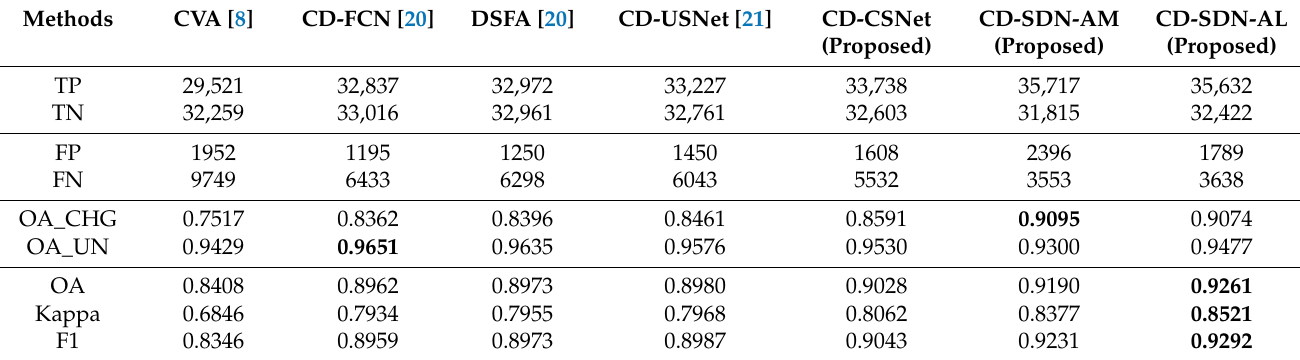
Table 3. The comparison of quantitative results on dataset ‘Bay